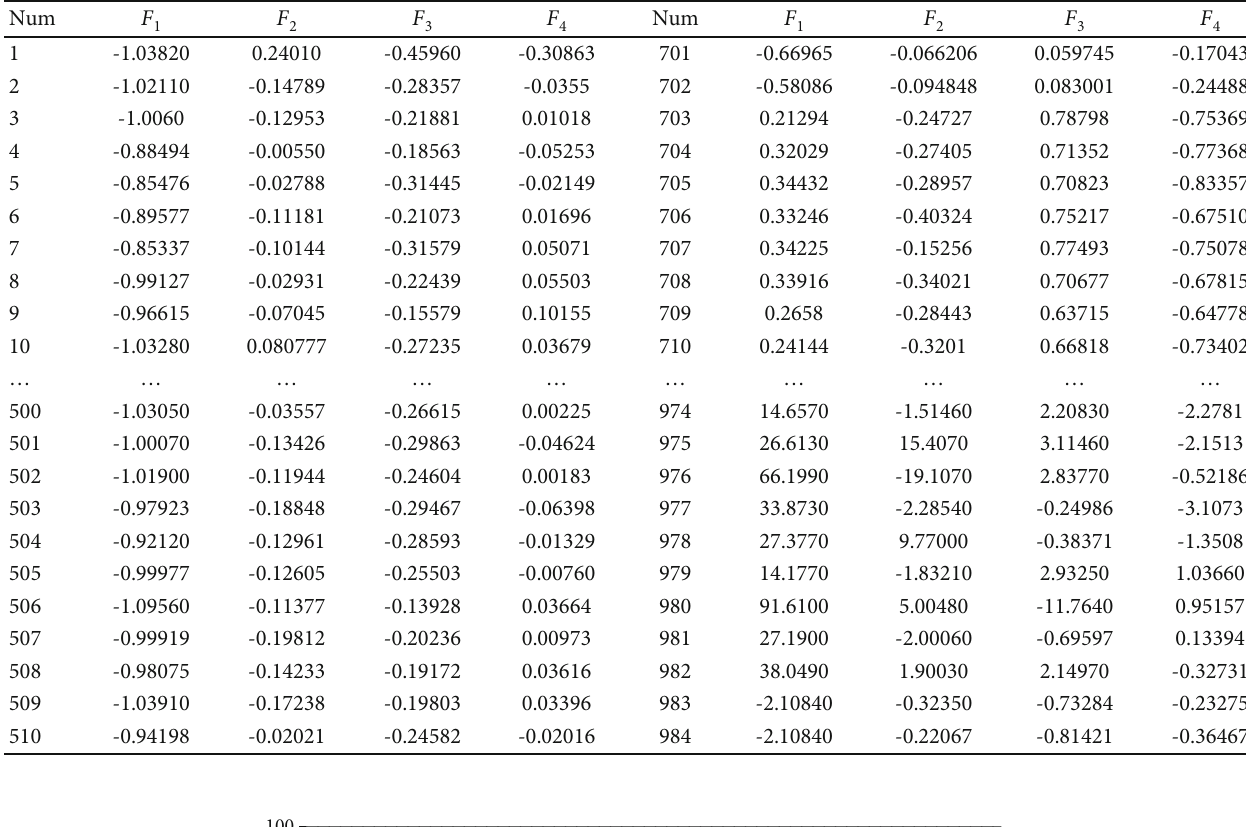
Table 5: Principal component calculation of feature parameters of vibration signals (part).